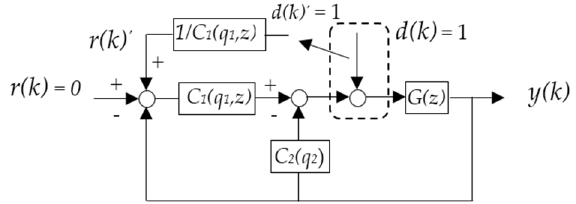
Figure 4. Closed ‐ loop of FB ‐ type 2DOF PI ‐ P control system. Figure 4. Closed-loop of FB-type 2DOF PI-P control